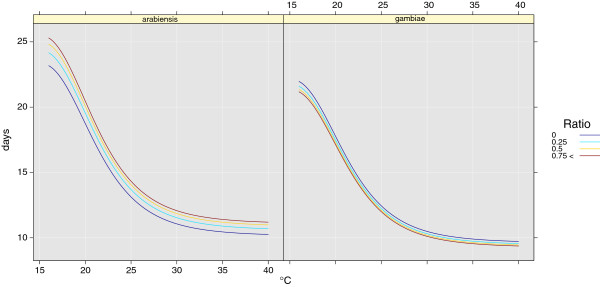
Water temperature according to development time in days from first instar to adult. Left panel: ratio of An. gambiae s.s. to An. arabiensis. When greater numbers of An. gambiae s.s. are present, An. arabiensis develop more slowly. Right panel: ratio of An. arabiensis to An. gambiae s.s.. When greater numbers of An. arabiensis are present, An. gambiae s.s. develop more quickly.